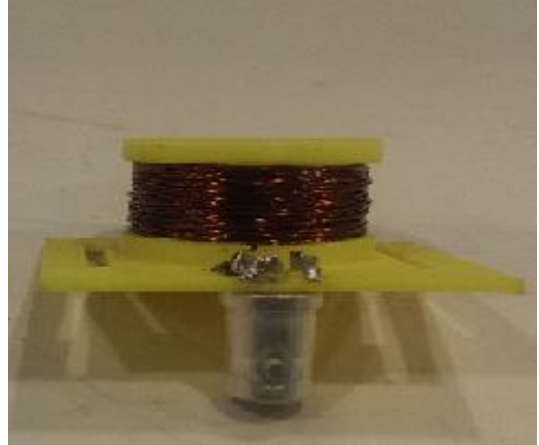
Figure 3. Manufacture coil sensor used for measurement of the leakage flux around the